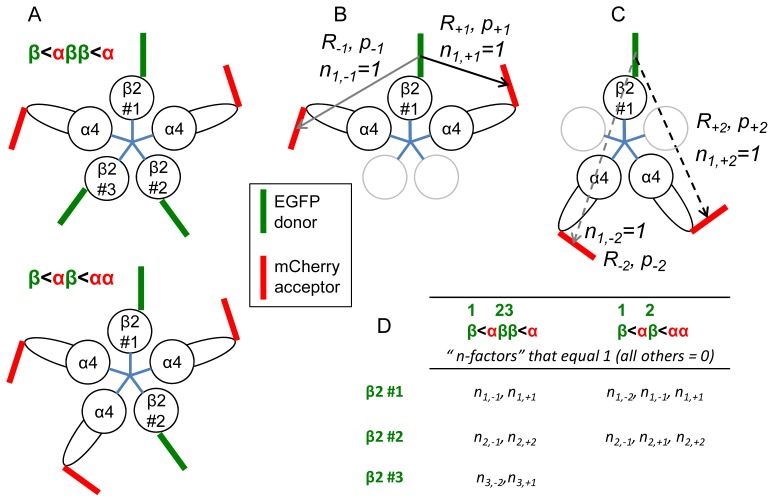
Diagrams depicting FRET analysis of nAChR stoichiometry. (A) Two examples of stoichiometry, thought to correspond to the major α4β2 nAChRs in brain [12]. Both stoichiometries contain two β2 < α4 interfaces. The < character implies a correctly polarized high-affinity ligand binding interface, contrasting with the arrows in (B) and (C) which denote energy transfer. The nAChR is viewed from the extracellular surface. In the top panel the stoichiometry is (α4)2(β2)3, and in the bottom panel (α4)3(β2)2. The donor molecules are labeled 1 through 3, as in the equations in the text; (B) Nomenclature for energy transfer to acceptors that are adjacent to the donor. The first subscript denotes the identity of the β2-EGFP donor subunit. The second subscript is ±1 for adjacent and non-adjacent energy transfer, respectively; the positive sign denotes clockwise transfer. β2-EGFP donor #1 is shown with two immediately flanking α4-mCherry acceptors. Because these two pathways exist, the “n-factors” n1, −1 = n1, +1 = 1. The arrows show the fluorophore separations R±1, R±2 and the corresponding energy transfer probabilities, p±1, p±2 Clockwise energy transfer is shown as a black arrow; anticlockwise, as gray. The remaining two subunits are shown in gray; they may be either donors or acceptors; (C) Nomenclature for energy transfer to acceptors that are non-adjacent to the donor. β2-EGFP donor #1 is shown with two α4-mCherry acceptors that are non-adjacent to the donor (but incidentally adjacent to each other). Because these two pathways exist, the “n-factors” n1, −2 = n1, +2 = 1. Other details as in (B); (D) Table showing the “n-factors” for the nAChR stoichiometries under consideration. See text.